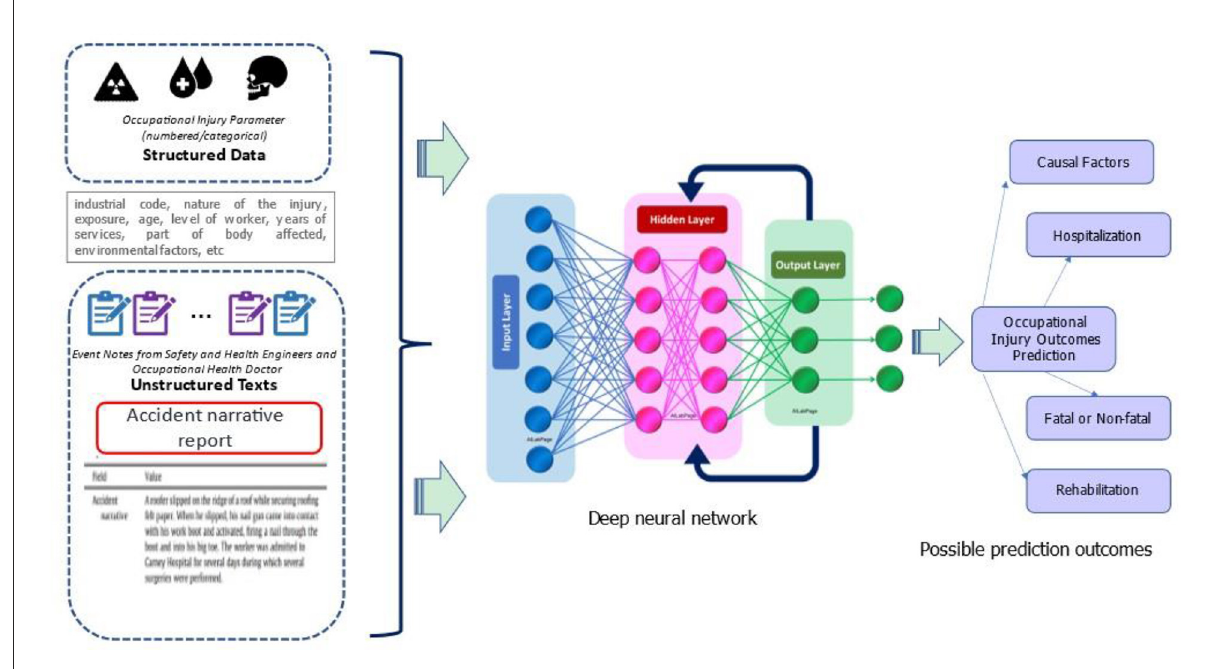
FIGURE5 Proposed framework of multimodal prediction